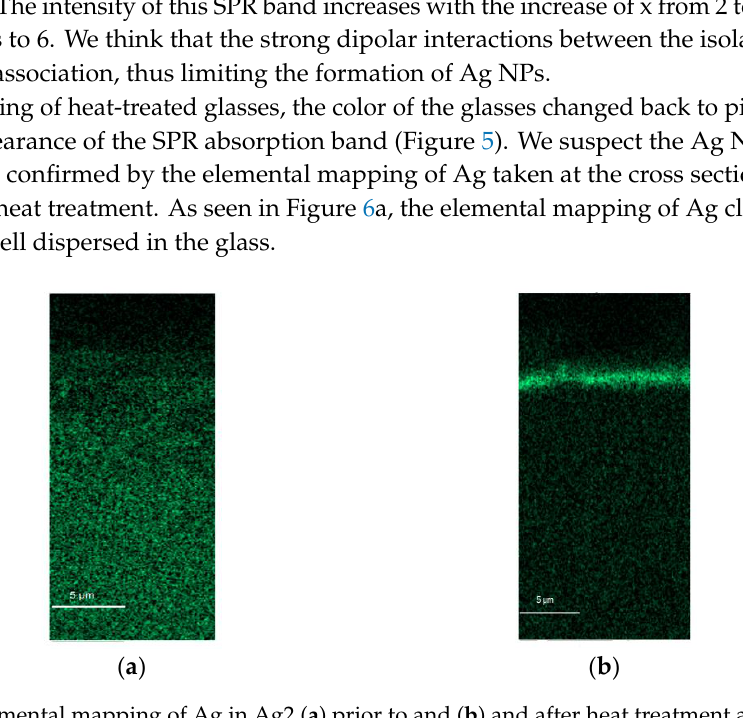
epoxy − 20 Figure 7. Ag concentration profile measured from the surface of the heat-treated glasses. As seen in Figure 7, an increase in x increases not only the thickness of the Ag layer precipitating at the surface of the glass but also the Ag content in the layer. The normalized visible emission spectra of the sample doped with 2 mol% of Ag 2 O (Ag2) prior to and after heat treatment are shown in Figure 8.